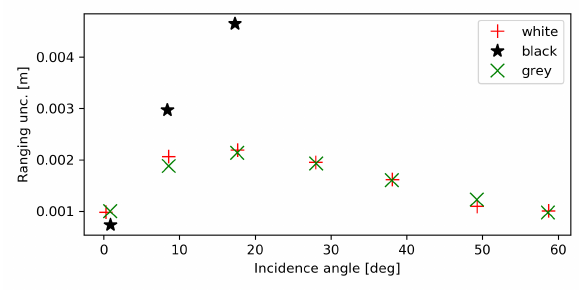
Figure 8. VZ-2000i ranging uncertainty vs. incidence angle for a constant range of 60m .